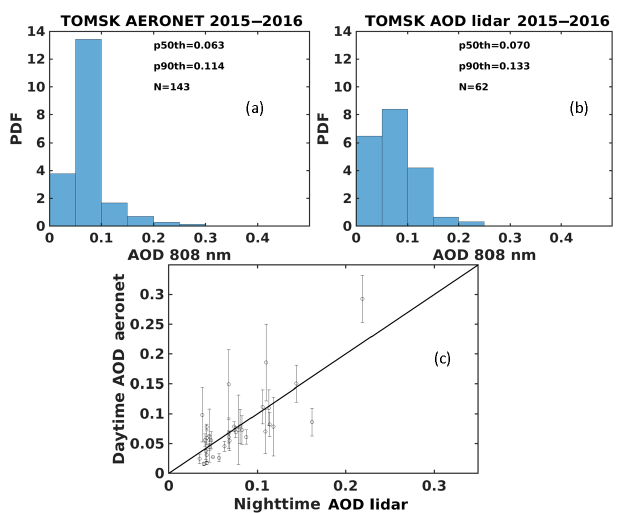
Figure 6. (a) PDF of daytime AOD from a sun photometer for lidar measurement days and (b) of night-time AOD calculated with the lidar-attenuated backscatter ratio measurement at the reference alti- tude z r . N is the number of observations, while p50th and p90th are respectively the median and 90th percentile of the AOD distribution. (c) Correlation plot of night-time lidar AOD versus sun-photometer daytime AOD when the time difference between the two measure- ments is less than 6h (35 cases out of 63 night-time lidar AOD). The error bar is the daily variability of the sun-photometer AOD.